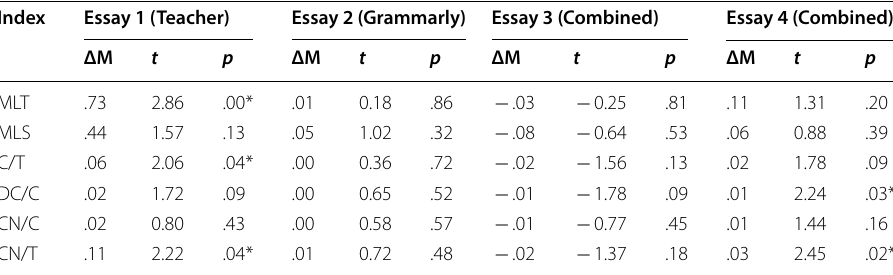
ΔM Mean difference between revised essay and its initial draft * p .05 ≤